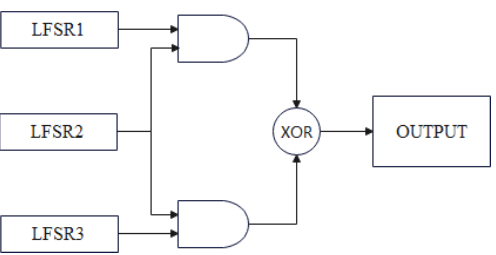
Figure 1. Geffe generator, which use three LFSRs and three logic gates.